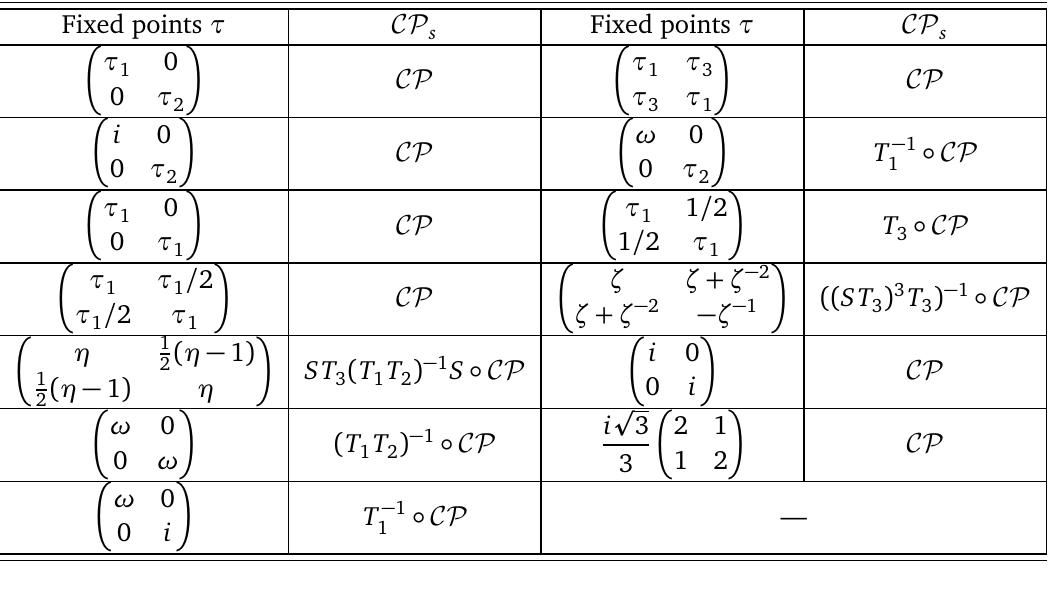
. The complex moduli are denoted by τ 2